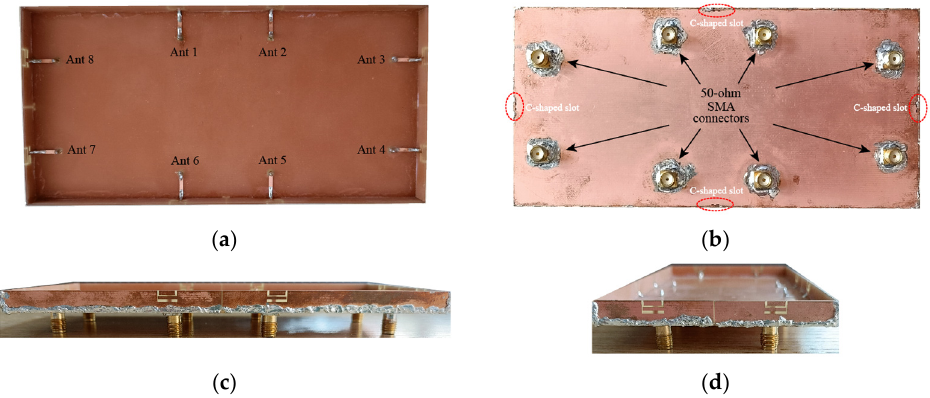
Figure 11. Photographs of the fabricated MIMO antenna system. ( a ): Front view, ( b ): back view, ( c ): long side view, and ( d ): short side view.